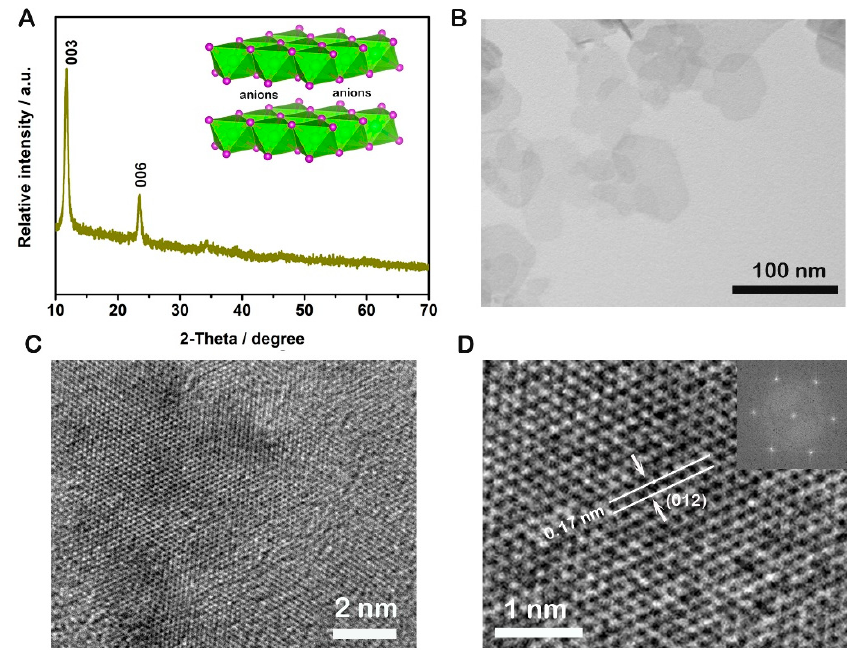
Figure 1. ( A ) X-ray diffraction (XRD) pattern of the Mn-Co layered double hydroxide (LDH) nanosheets; ( B ) Transmission electron microscopy (TEM) image of the Mn-Co LDH nanosheets; ( C ) High-resolution TEM (HRTEM) image of the Mn-Co LDH nanosheets; ( D ) corresponding selected area electron diffraction (SAED) of the Mn-Co LDH nanosheets.